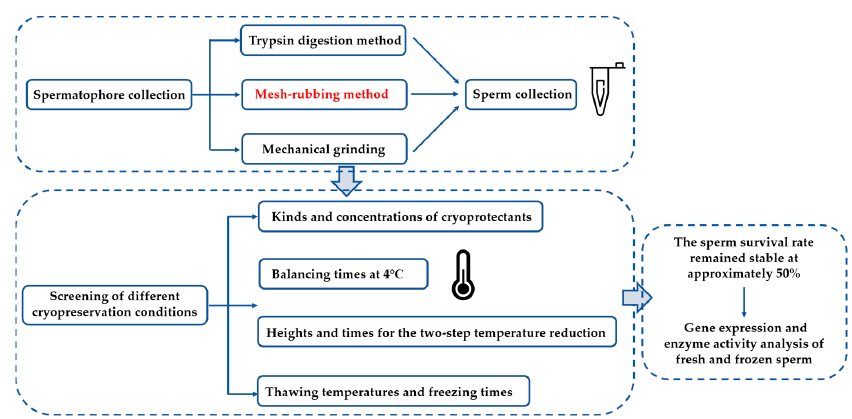
Figure 9. The flow chart of the sperm cryopreservation procedure in P. trituberculatus .